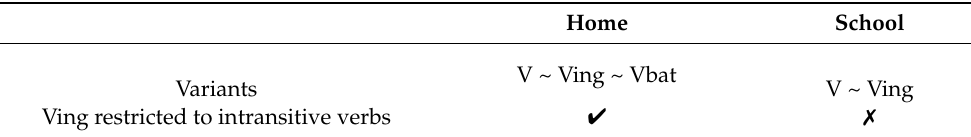
Table 2. Summary of HOME and SCHOOL verb morphology variable systems.